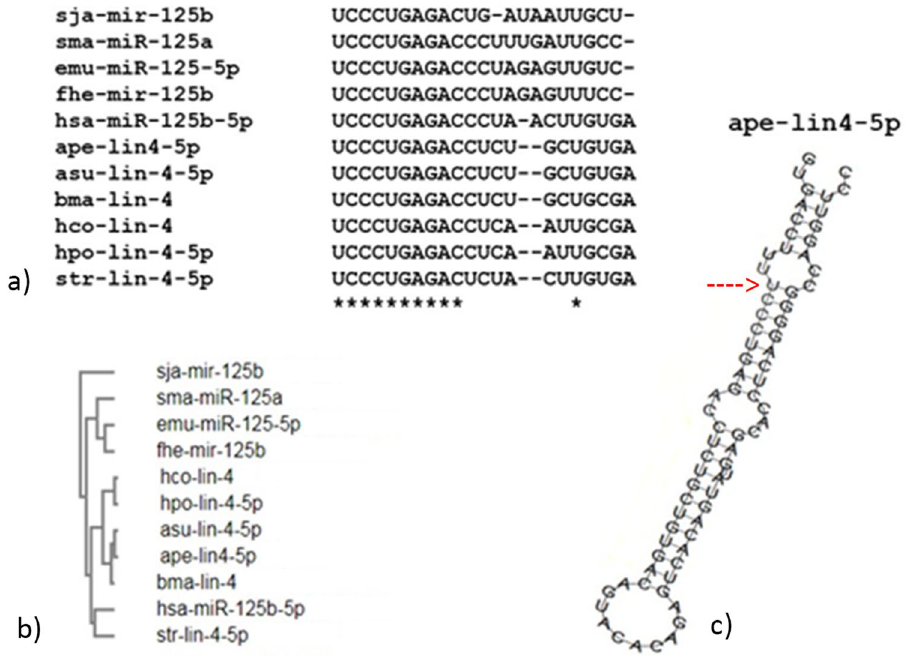
A. suum ; ape: A. pegreffii present study; bma: B. malawi ; hsa: H. sapiens ; str: S. ratti ). Complete identity is highlighted by an asterisk, while dashes indicate nucleotide deletions. The dendrogram of aligned miRNAs is shown in ( b ) and hairpin structure of ape-lin4 with the first nucleotide of matures sequence indicated with a red arrow is available in ( c ), according to RNA